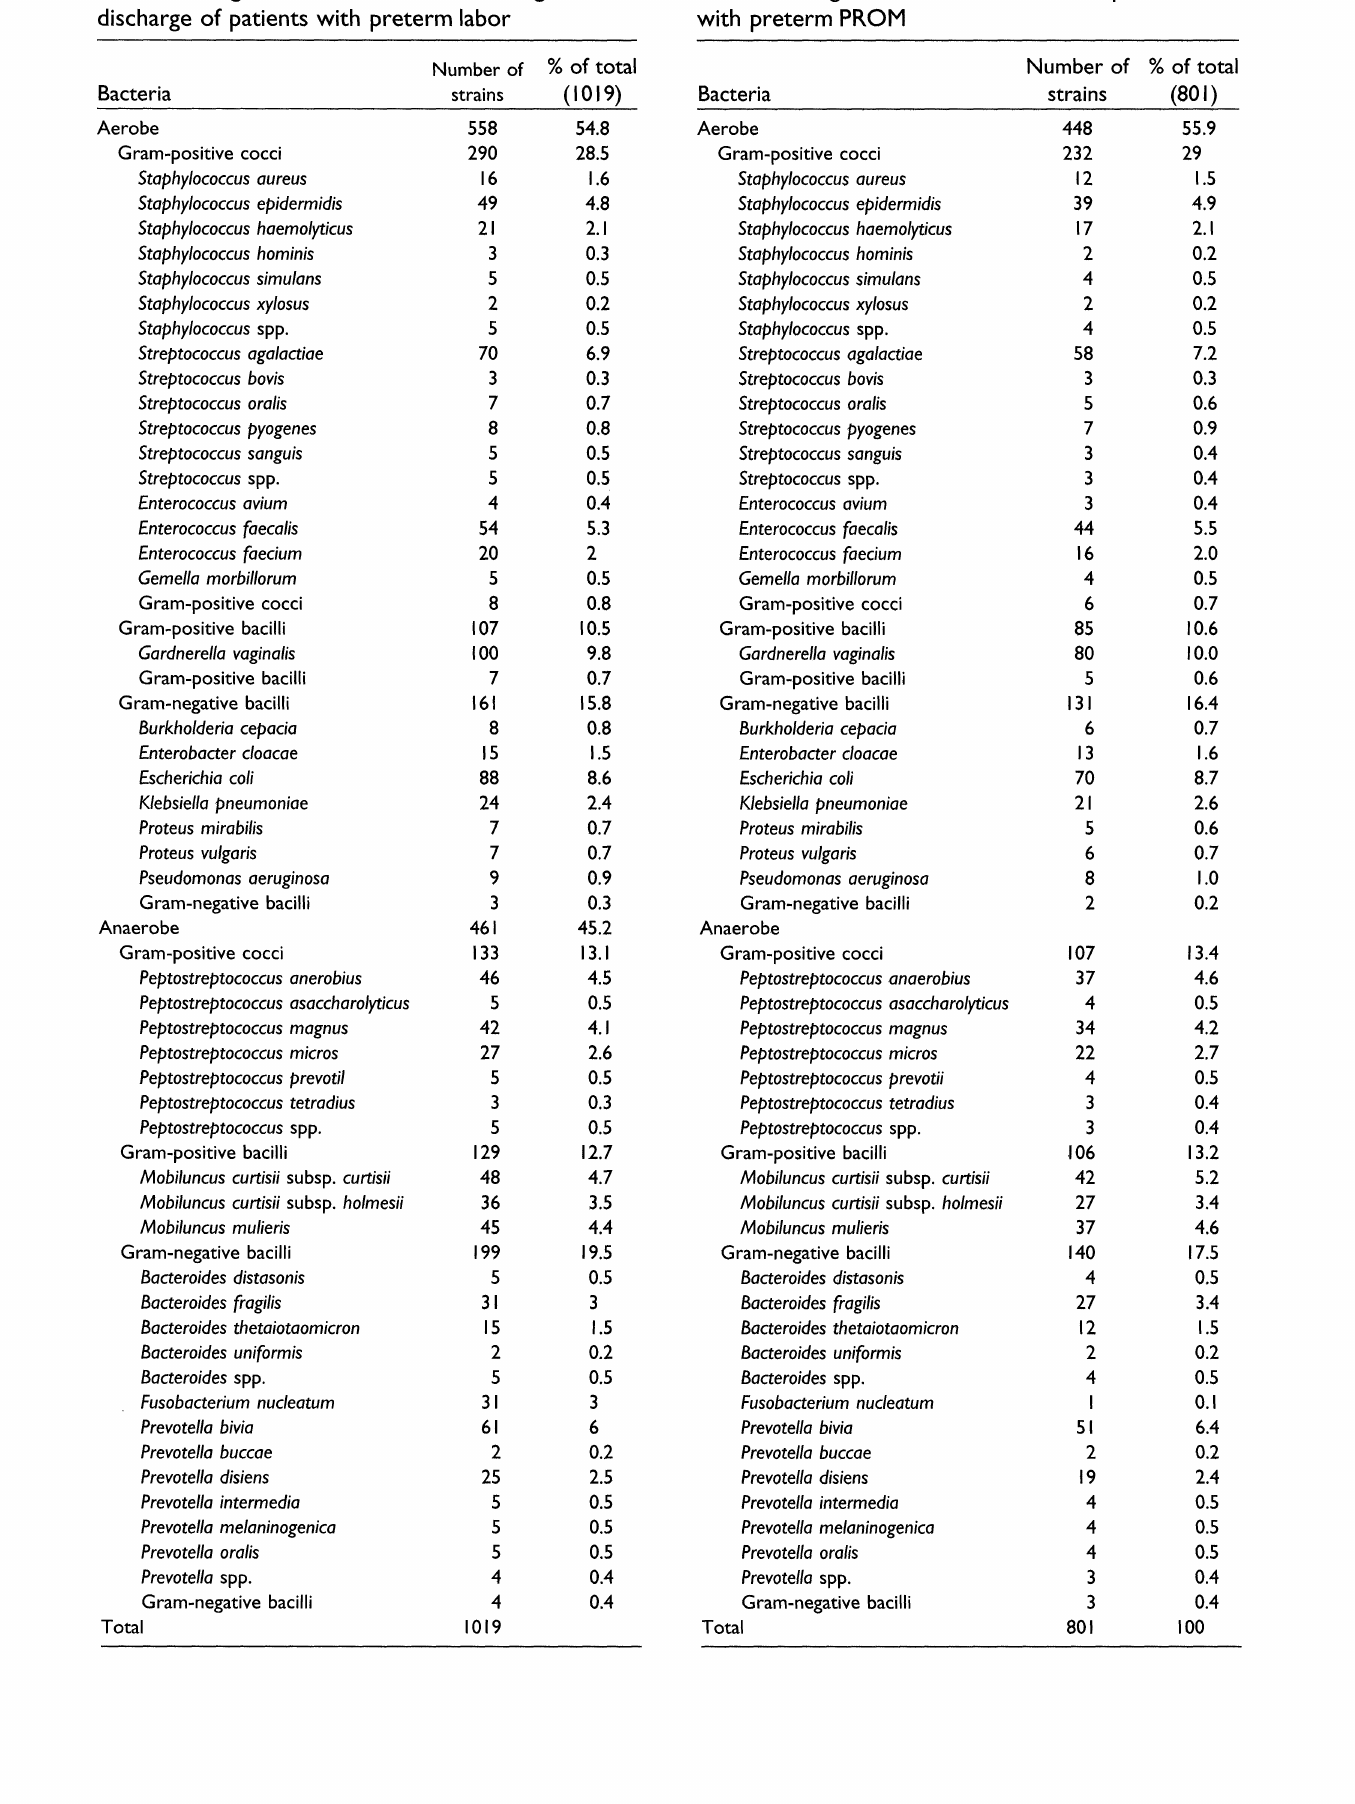
TABLE 3. Organisms detected from the vaginal discharge of patients with preterm labor